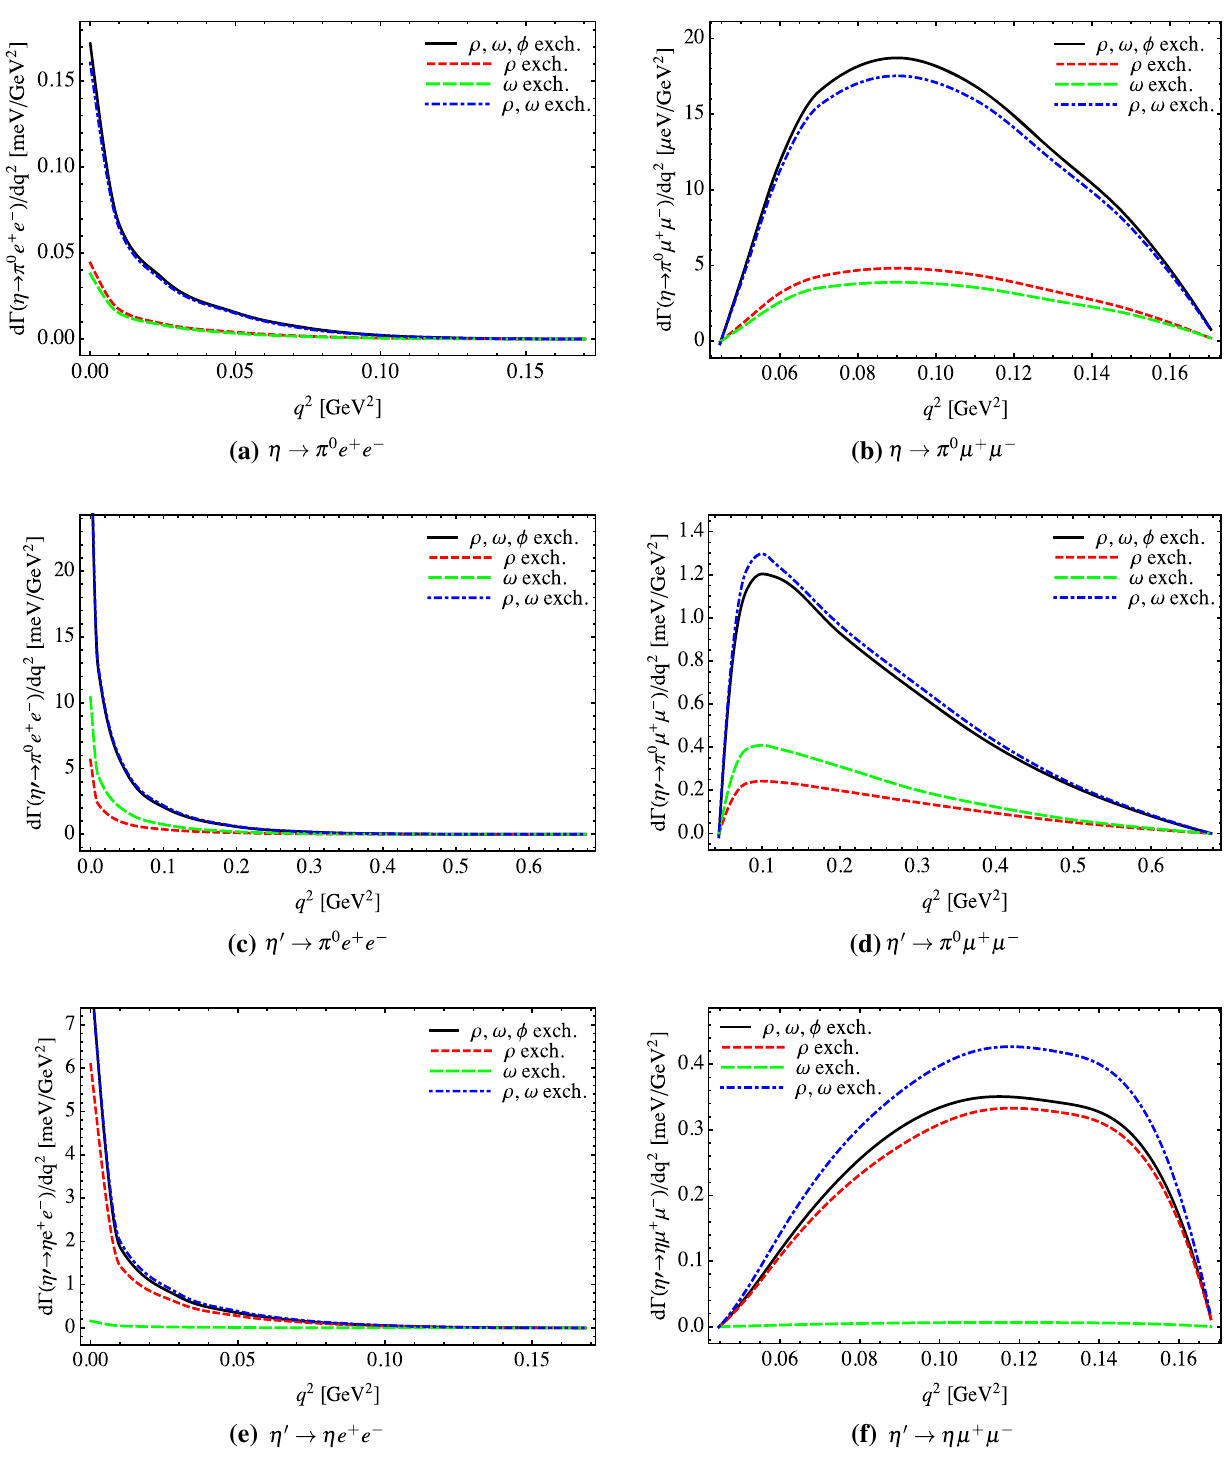
Fig. 2 Dilepton energy spectra corresponding to the six C -conserving semileptonic decay processes η ( (cid:2) ) → π 0 l + l − and η (cid:2) → η l + l − ( l = e or μ ) as a function of the dilepton invariant mass q